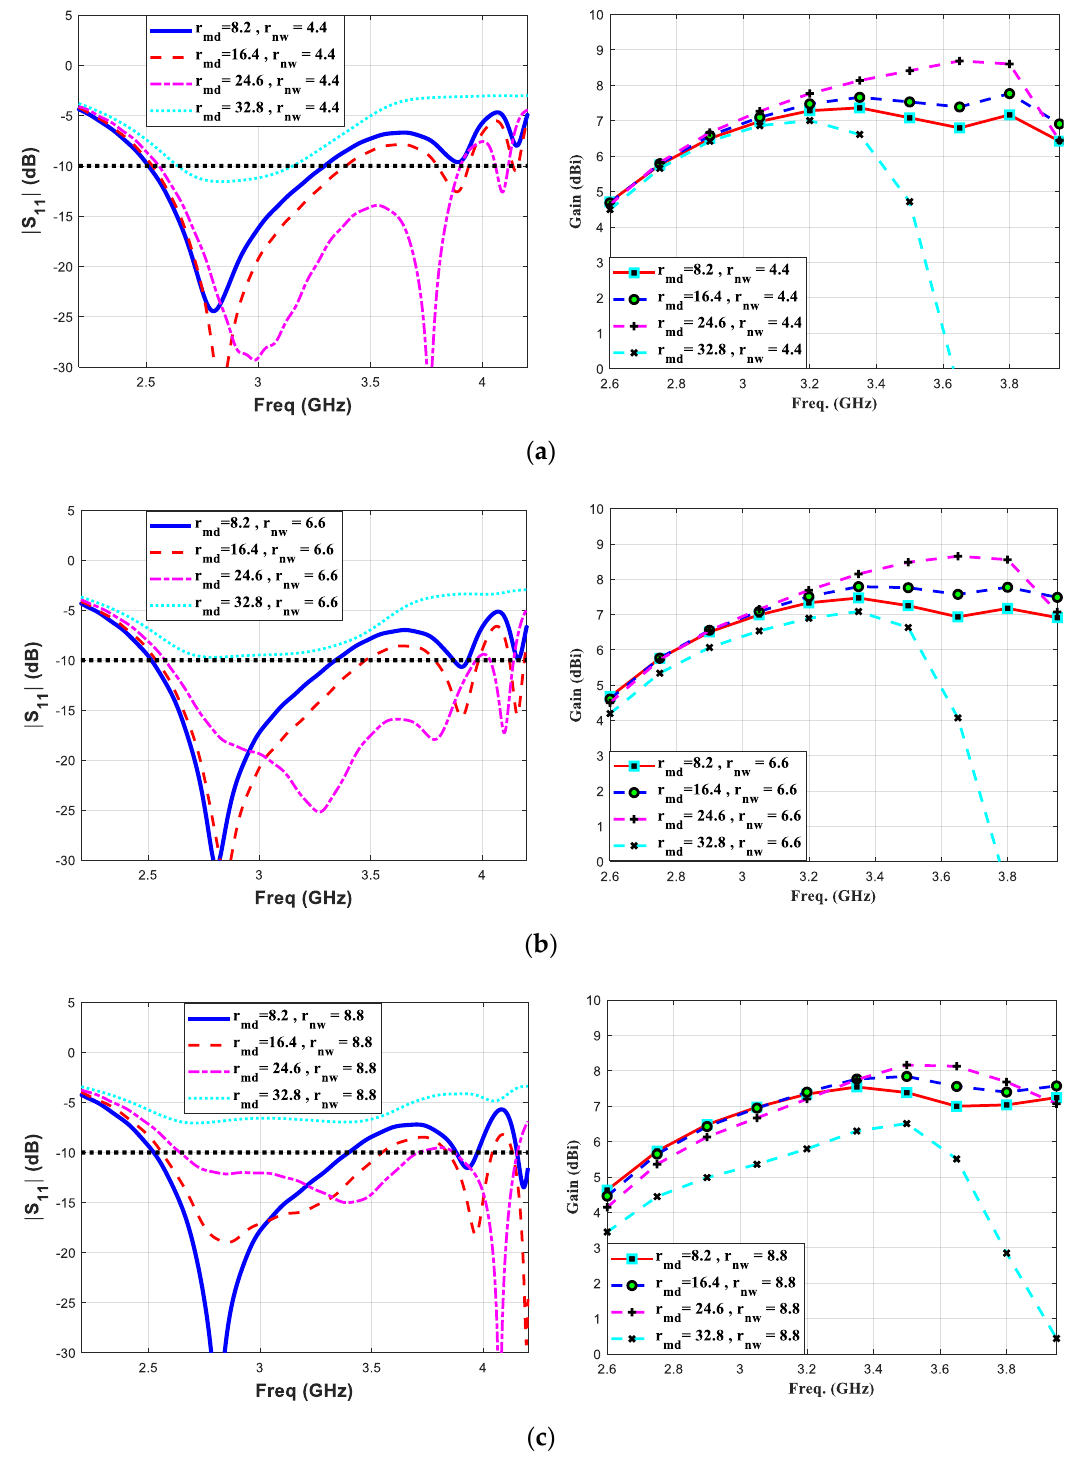
Figure 2. Parametric study of proposed antenna structural parameters based on reflection coefficient and gain performance analysis with ( a ) r nw = 4.4 mm, ( b ) r nw = 6.6 mm and ( c ) r nw = 8.8 mm.